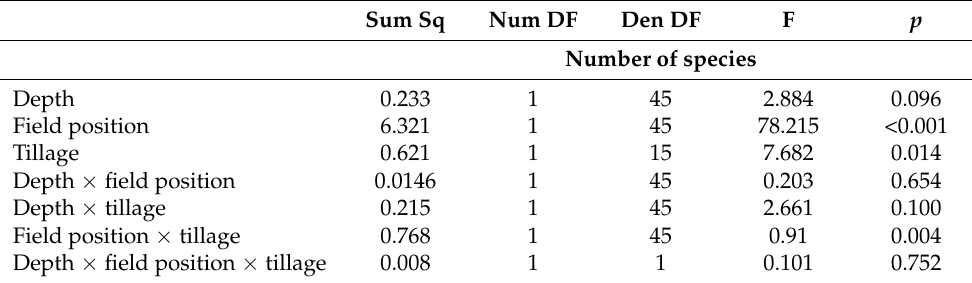
Figure 4. Boxplots of the number of species ( left ) and seeds ( right ) in field interior and field edge for different soil depths on low-tillage and conventional tillage farms (tillage: n = 9; low-tillage: n = 8). Significant pairwise differences are indicated by different letters (pairwise comparisons, p -value ≤ 0.05, Tukey-corrected). Table 1. Effects of soil depth, field position, and tillage regime on seed and species number assessed with linear mixed models (ANOVA). Sum Sq: sum of squares; Num DF: number of degrees of freedom, Den DF: denominator degrees of freedom; F: F-value; p : probability